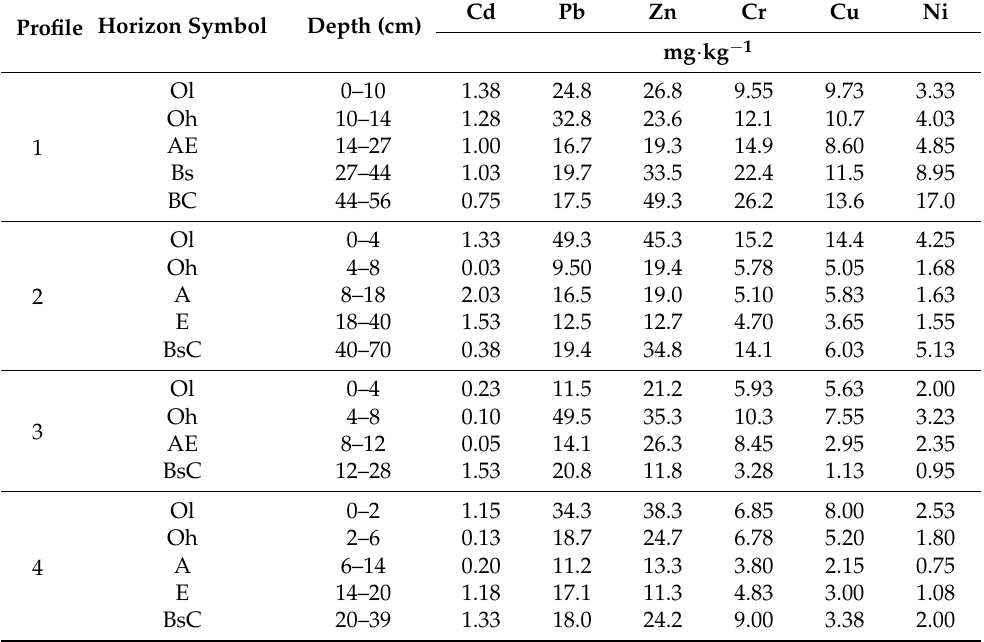
Table 4. Trace elements content in studied